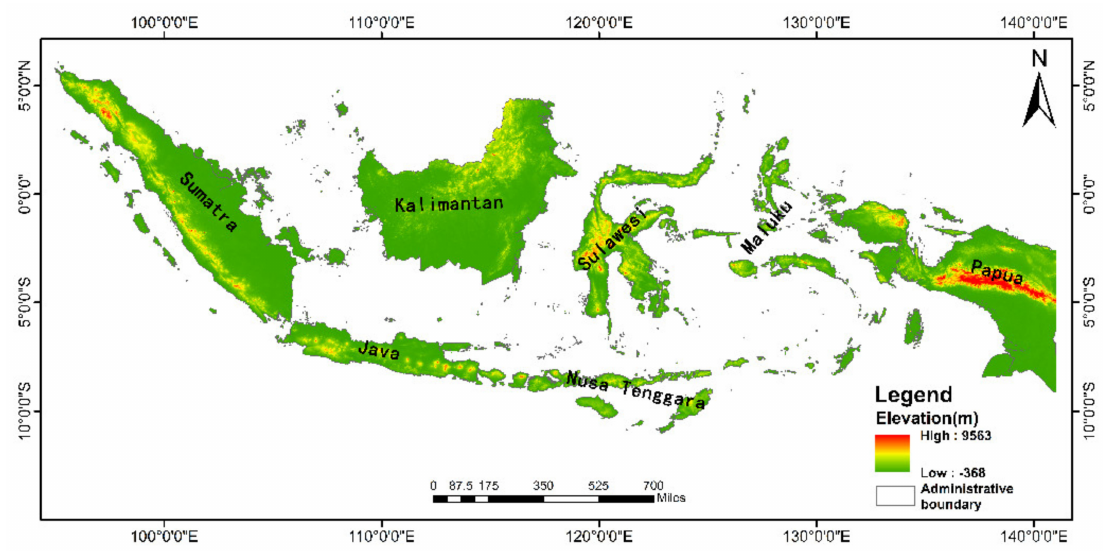
Figure 1. Digital elevation model (DEM) map of Indonesia.